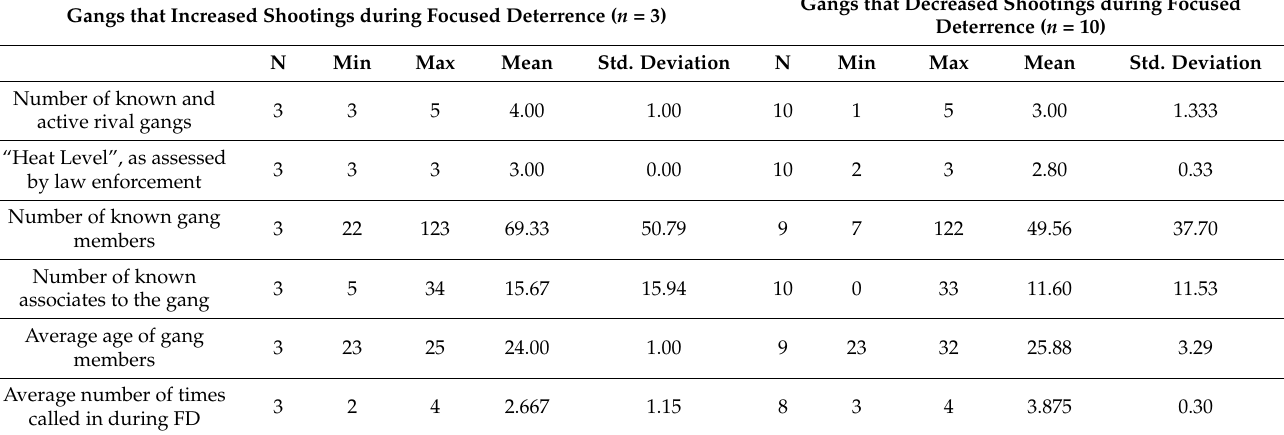
Table 1. Gang-level descriptive statistics, by change in